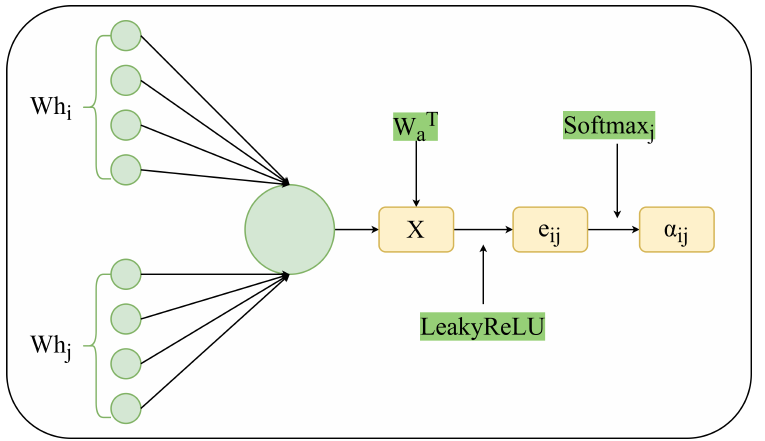
Figure 8. Attention